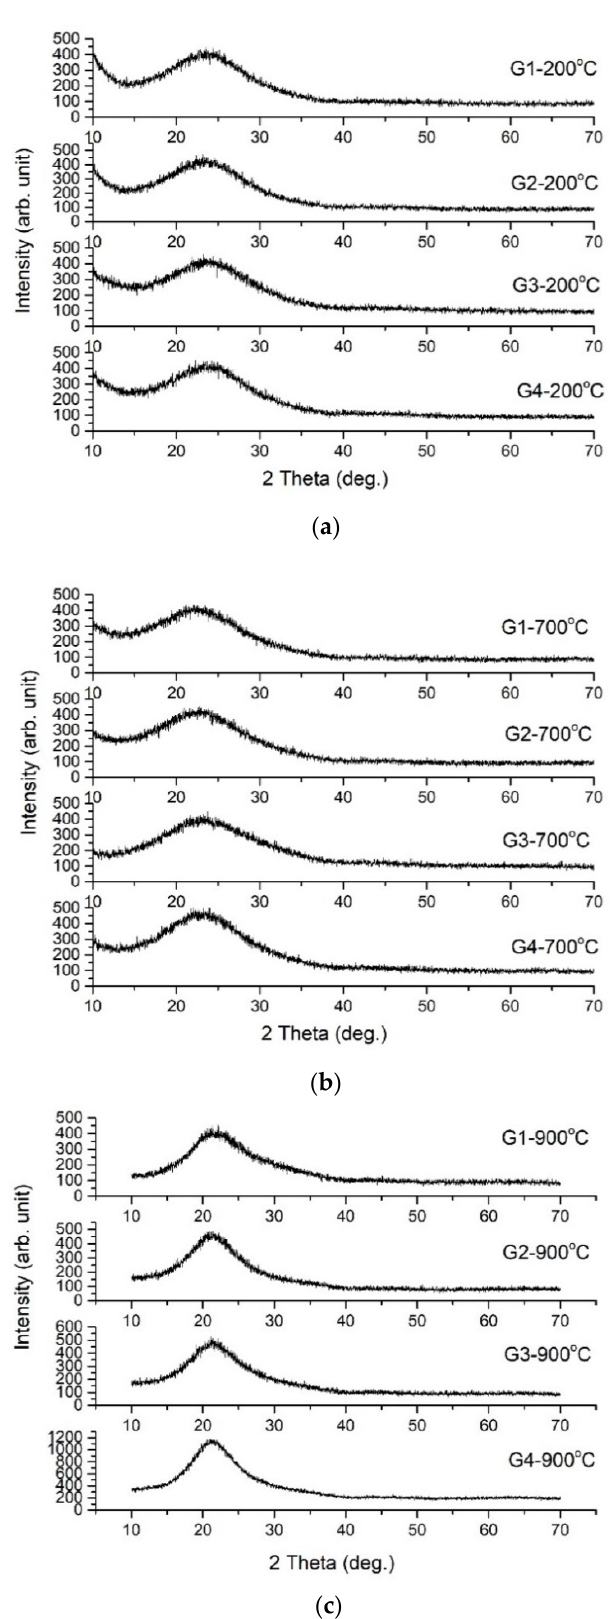
Figure 2. XRD patterns of powders G1–G4 treated at ( a ) 200 °C, ( b ) 700 °C and ( c ) 900 °C.